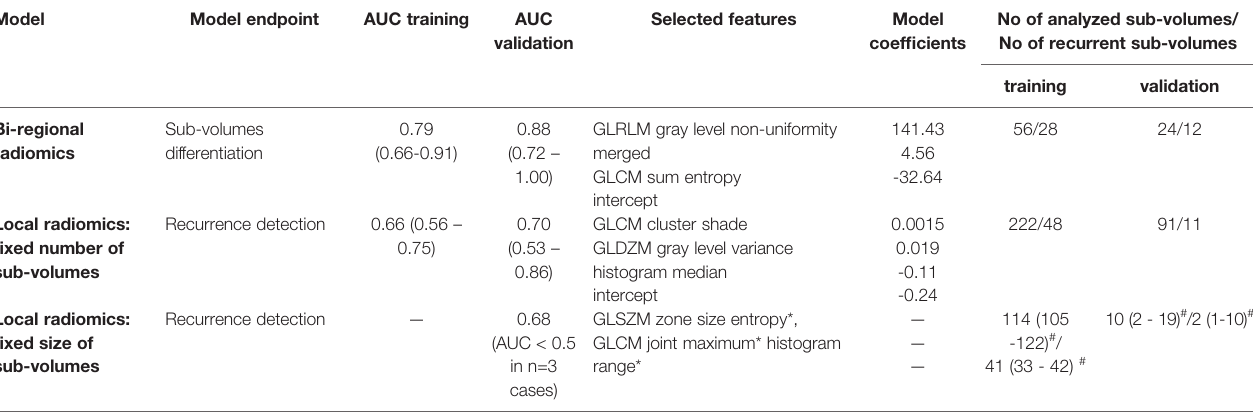
TABLE 2 | Details of the fi nal radiomics